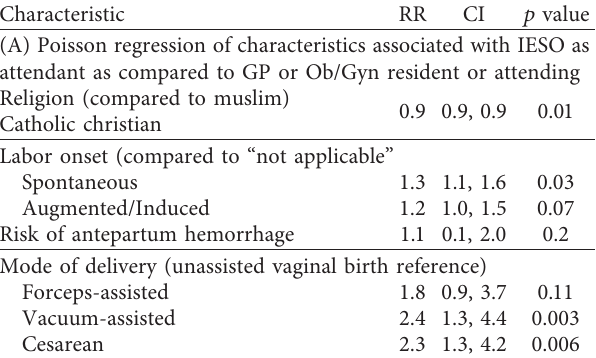
(B) Individual logistic regressions, adjusted for significant findings in Table 4, to determine association of cesarean birth with outcomes significant in bivariate comparisons (Table 3)